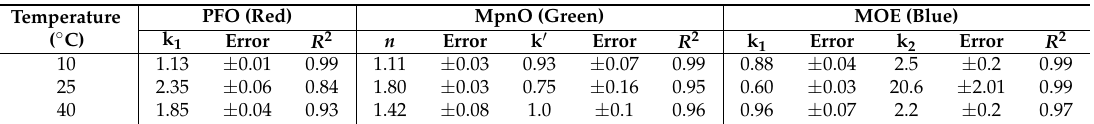
Table 8. Parameters and characteristics of experimental data fitted at different temperatures for the studied kinetics models (6.25% ammonia concentration).